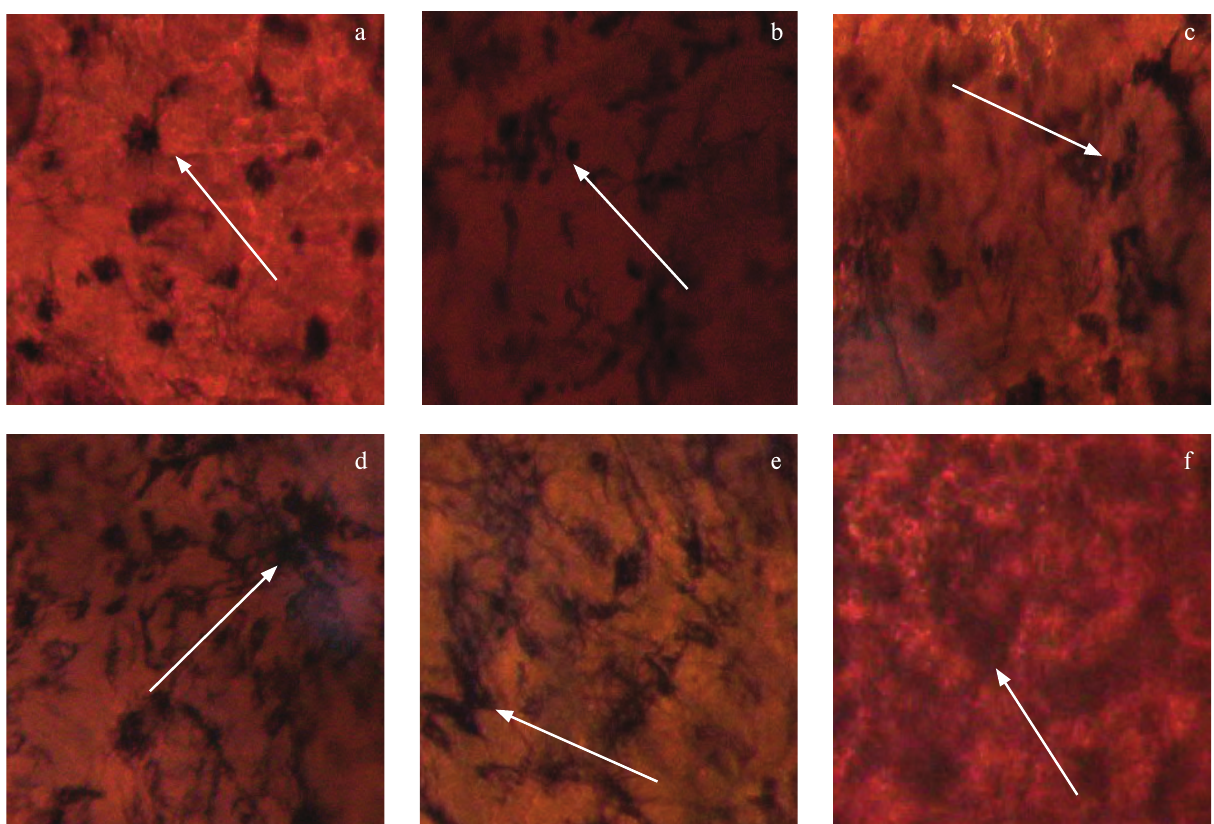
Fig. 2. The ability of VH10 cells to adhere and divide on the coladerm-beta glucan membrane surface after 1 (a), 2 (b), 3 (c), 6 (d) and 7 (e) days of cultivation. The membrane without VH10 cells was used as a control (f). Adhered cells are indicated by the arrows. Magnification: